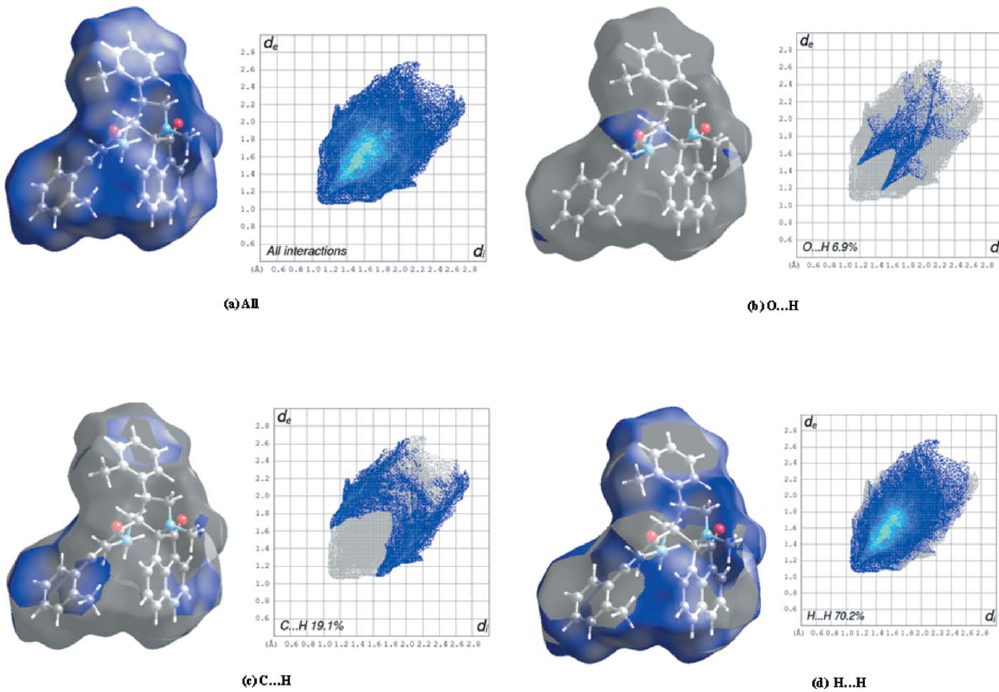
Figure 9 Hirshfeld surface of (II) mapped over shape-index and d norm and decomposed fingerprint plots of the dominant